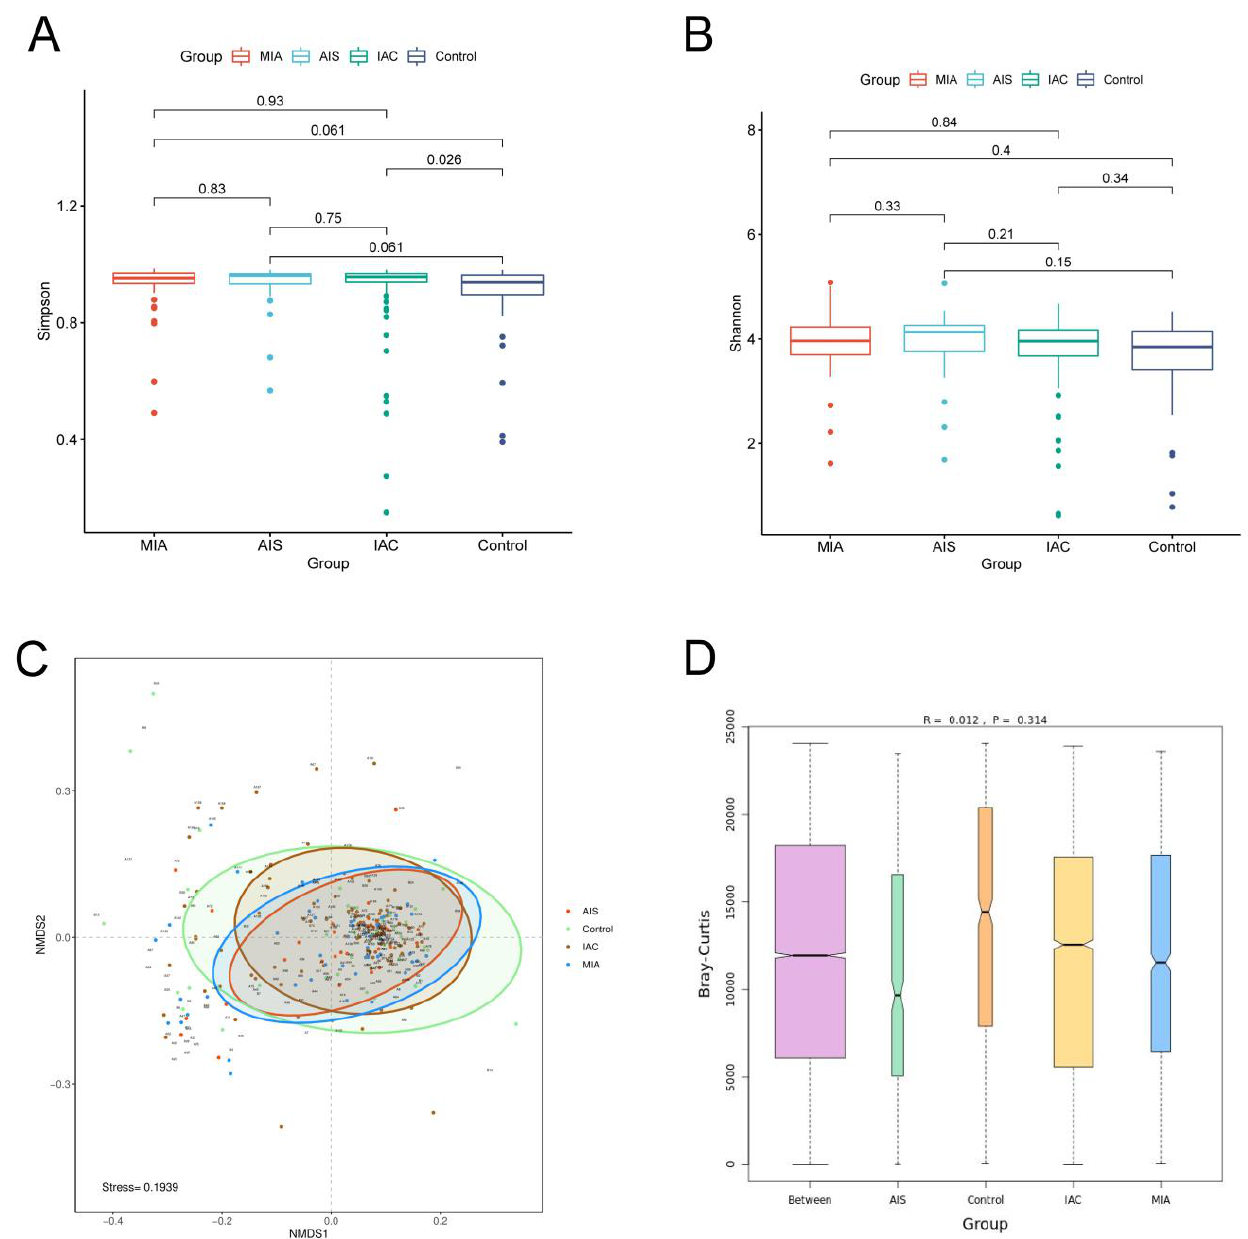
Figure 4. Diversity analysis for microbiota among four groups based on varying histopathology. Alpha diversity analysis among four groups based on the ( A ) Simpson index and ( B ) Shannon index; ( C ) beta diversity analysis via NMDS based on the Bray − Curtis distance. ( D ) ANOSIM analysis box plot.